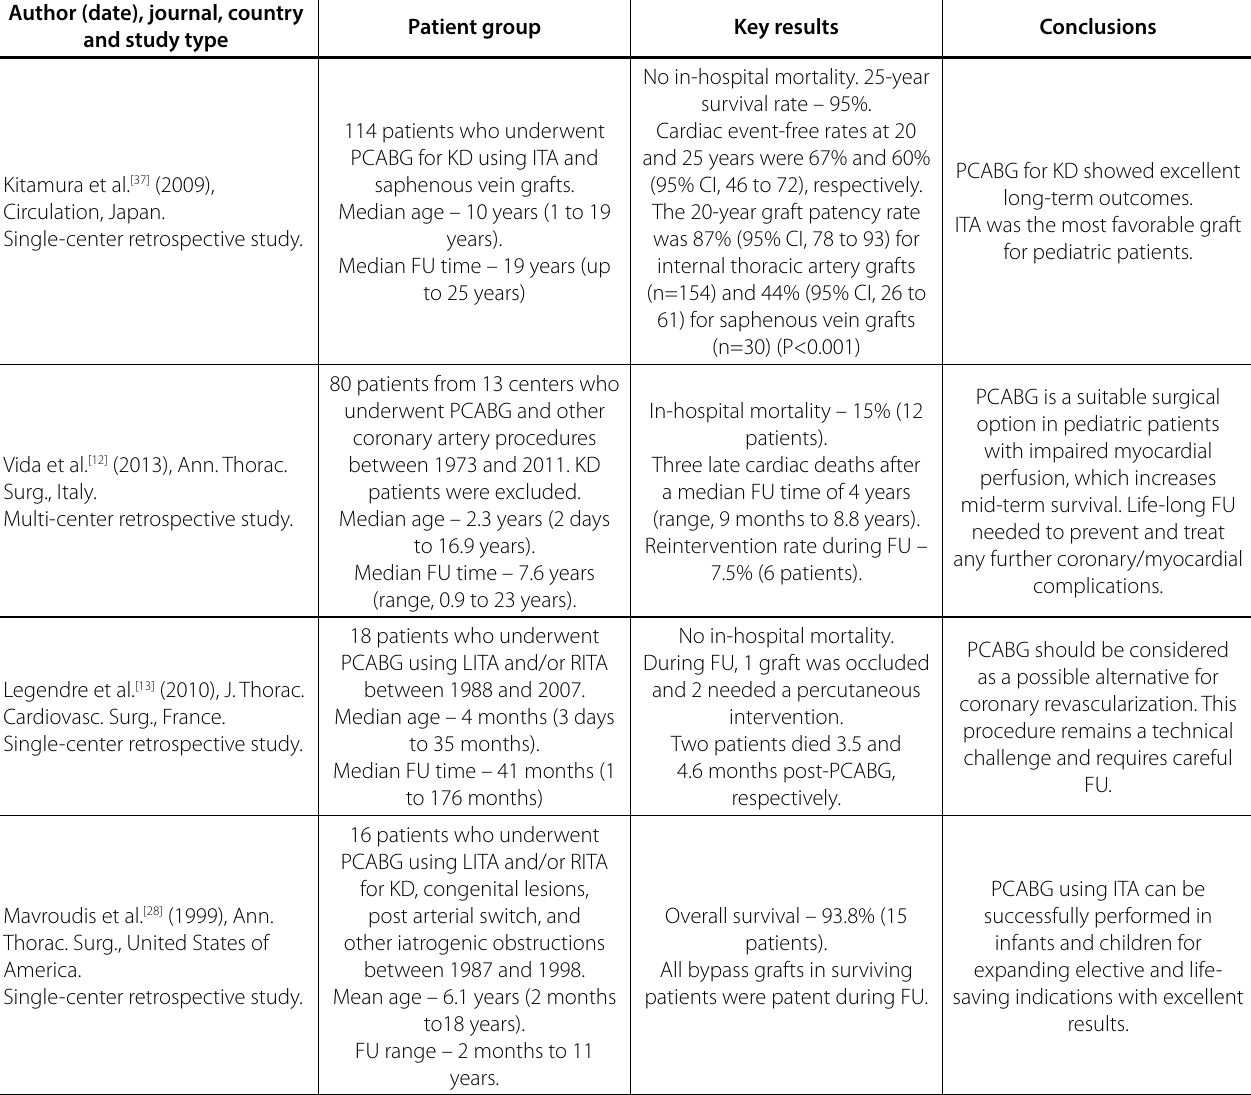
Table 1 . Best evidence publications for pediatric coronary artery bypass grafting